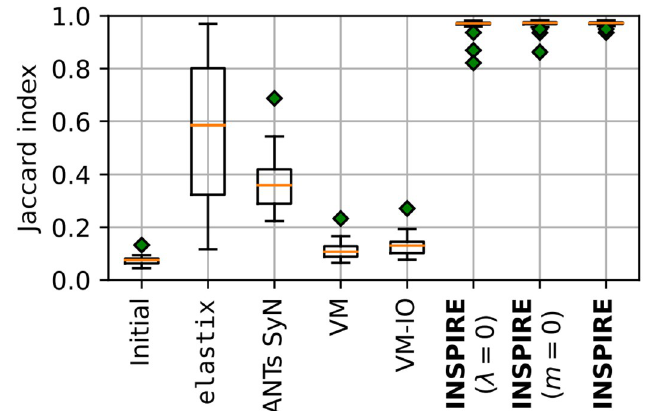
Fig 4. Box-and-whiskers plot of Jaccard index on the Retinal dataset for the considered methods. A higher score is better. INSPIRE exhibits very good performance for all cases, while the competing methods are much less reliable and with substantially lower performance on average. Empirical mean and std-dev of the Jaccard index computed on the ground-truth vessel masks for respective method are: (Initial, J = 0.074 ± 0.016), ( elastix , J = 0.565 ± 0.270), (ANTs SyN, J = 0.368 ± 0.099), (VoxelMorph (VM) J = 0.112 ± 0.032), (VM-IO J = 0.129 ± 0.038), (INSPIRE ( λ = 0), J = 0.965 ± 0.029), (INSPIRE ( m = 0), J = 0.966 ± 0.026), (INSPIRE, J = 0.972 ± 0.008). The results corresponding to image 2 in the dataset are shown in Fig